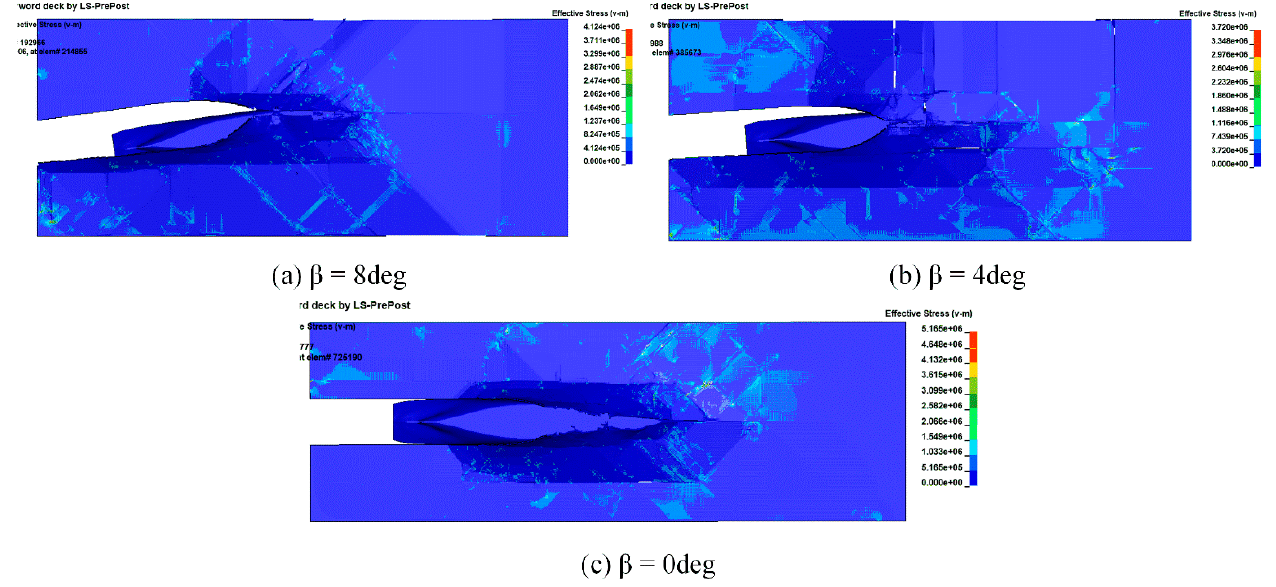
Figure 16. Comparison of icebreaking under different drift